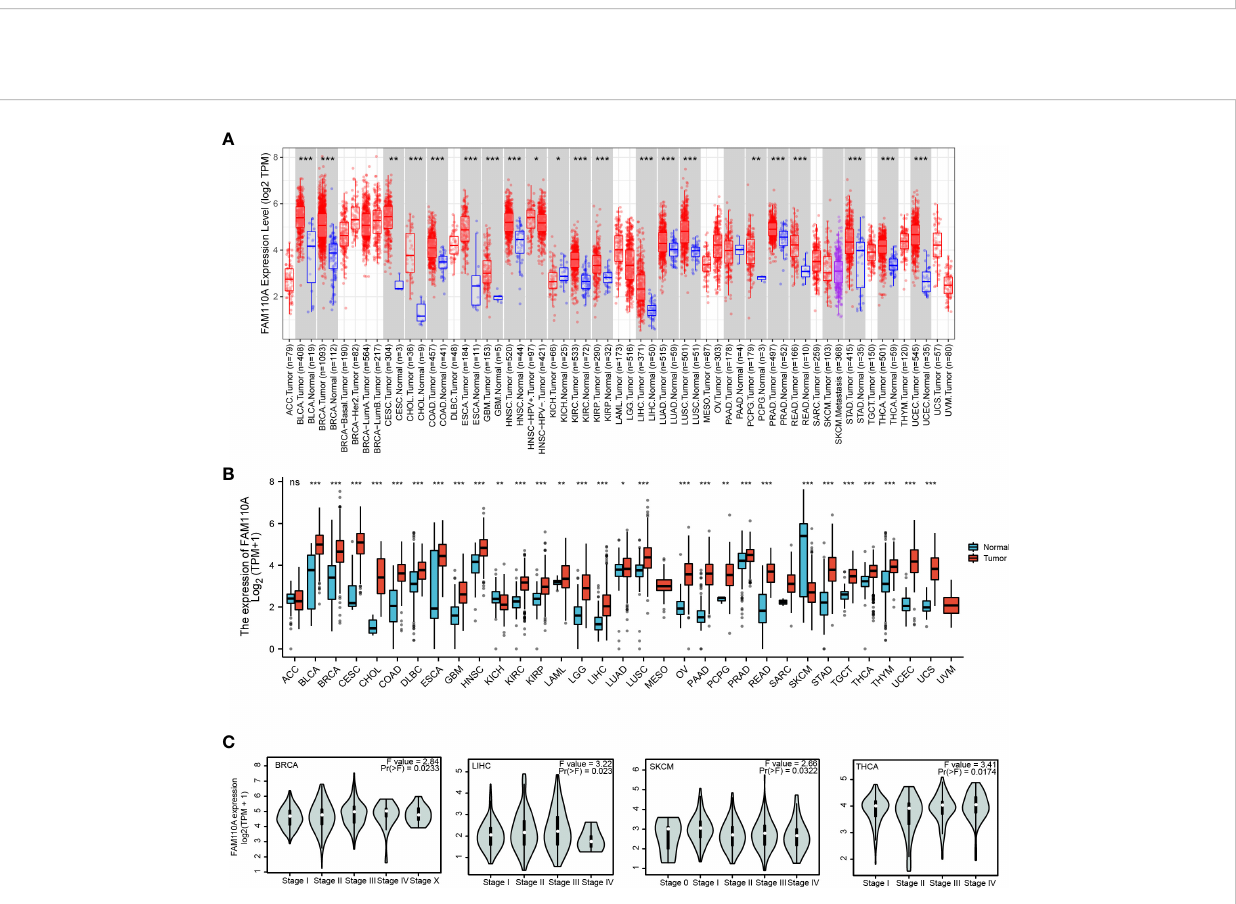
FIGURE 2 FAM110A expression in various tumor tissues. (A) FAM110A expression levels in pan-cancer from TCGA database were analyzed by TIMER2.0. (*P<0.05, **P<0.01, ***P<0.001). (B) FAM110A expression differences between tumor and normal tissues in pan-cancer from the TCGA and GTEx databases. (*P<0.05, **P<0.01, ***P<0.001). (C) The correction between FAM110A expression and the pathological stages of BRCA, LIHC, SKCM and THCA using the GEPIA2 database.